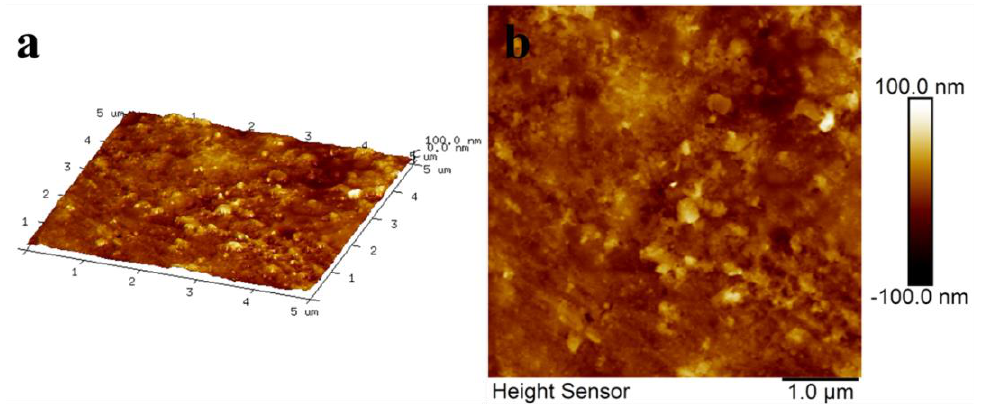
Figure 3. AFM images of the modified nanoscale titania coating: ( a ) 3D stereogram, ( b ) 2D topogra- phy.